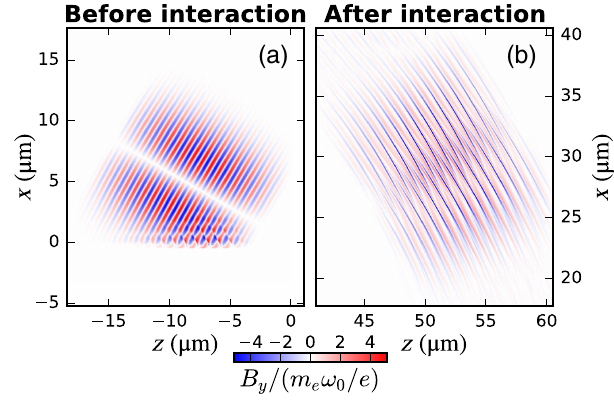
FIG. 6. Results from a 3D PIC simulation. We show the laser magnetic field in the incidence plane with radial polarization, either (a) 10 μ m before or (b) 60 μ m after